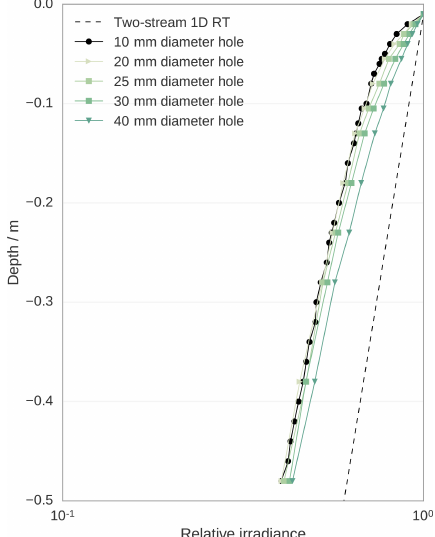
Figure 11. Influence of the air gap between the 10mm diameter rod and snow simulated with MCML at 400nm for a homogeneous snowpack with SSA of 30m 2 kg − 1 and density of 350kgm − 3 . The 1-D model shows the reference profile in the ideal case (no rod and no